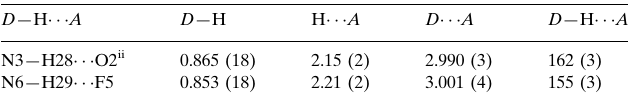
Hydrogen-bond geometry (A˚ , (cid:3)